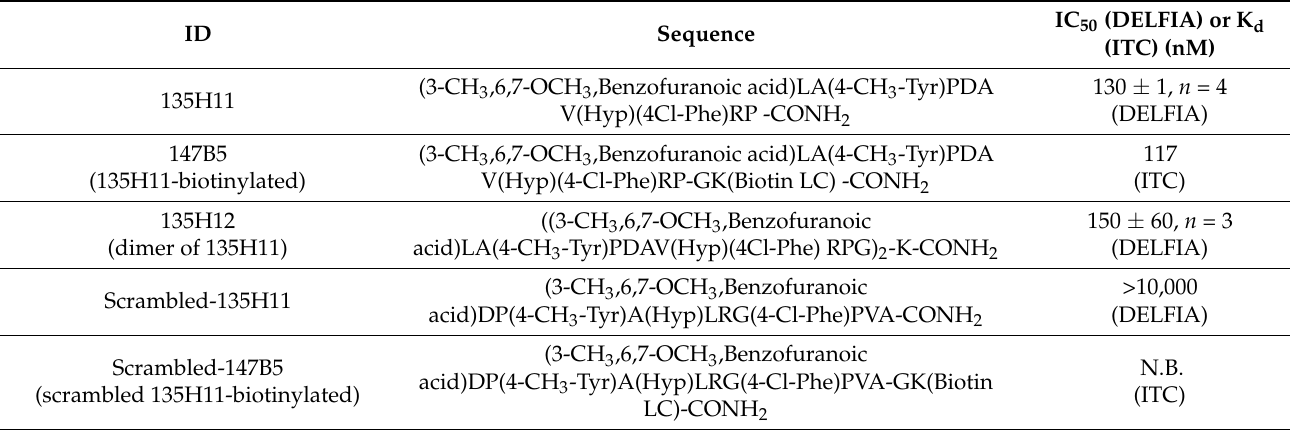
Figure 1. Affinity of EphA2-LBD-targeting agents as detected by ITC (panels A and B) or DELFIA (panel C). ( a ) ITC curve for agent 147B5 for EphA2-LBD (K d = 117 nM). ( b ) ITC curve for the scrambled version of 147B5 against EphA2-LBD, no binding detected. ( c ) DELFIA dose–response curves for agents 135H11 (purple, IC 50 = 130 nM), 135H12 (blue, IC 50 = 150 nM), or the scrambled version of 135H11 (green, no inhibition). Table 1. Sequences of agonistic agents cited in the present report. IC 50 values (nM) were derived from the DELFIA assay while dissociation constant (Kd) values were obtained by reverse ITC measurements. Reported standard errors represent the indicated number of experiments, each having duplicate measurements. Hyp = trans 4-hydroxy-L-proline. N.B. No binding detected by ITC (see also Figure 1). LC indicates a long 6 atom hydrocarbon chain between the biotin and the amide bond at the C-terminus of the